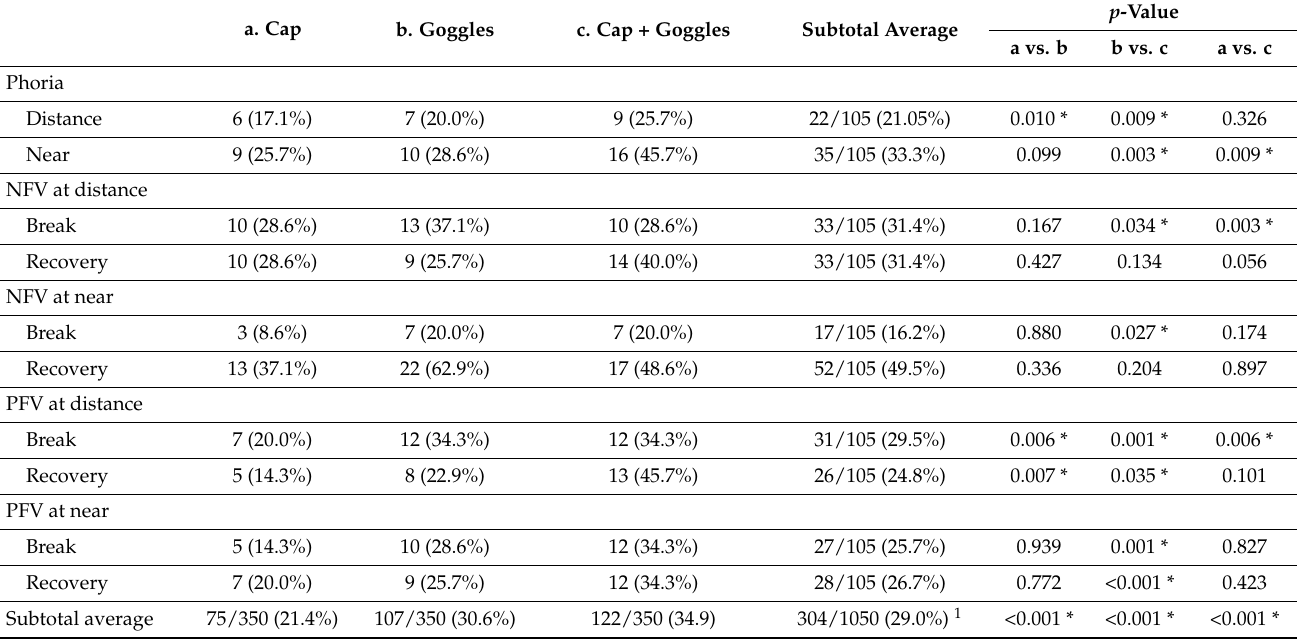
Table 4. Frequency of changes in phoria and in negative and positive fusional vergence.